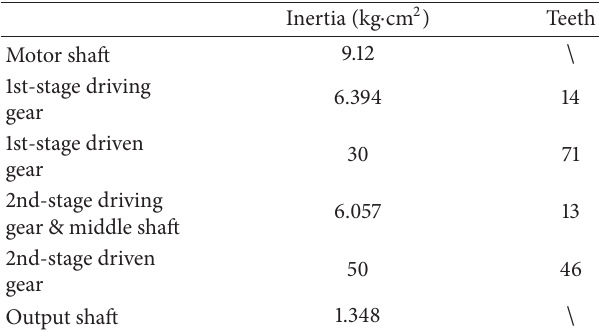
Table 1: Gearbox